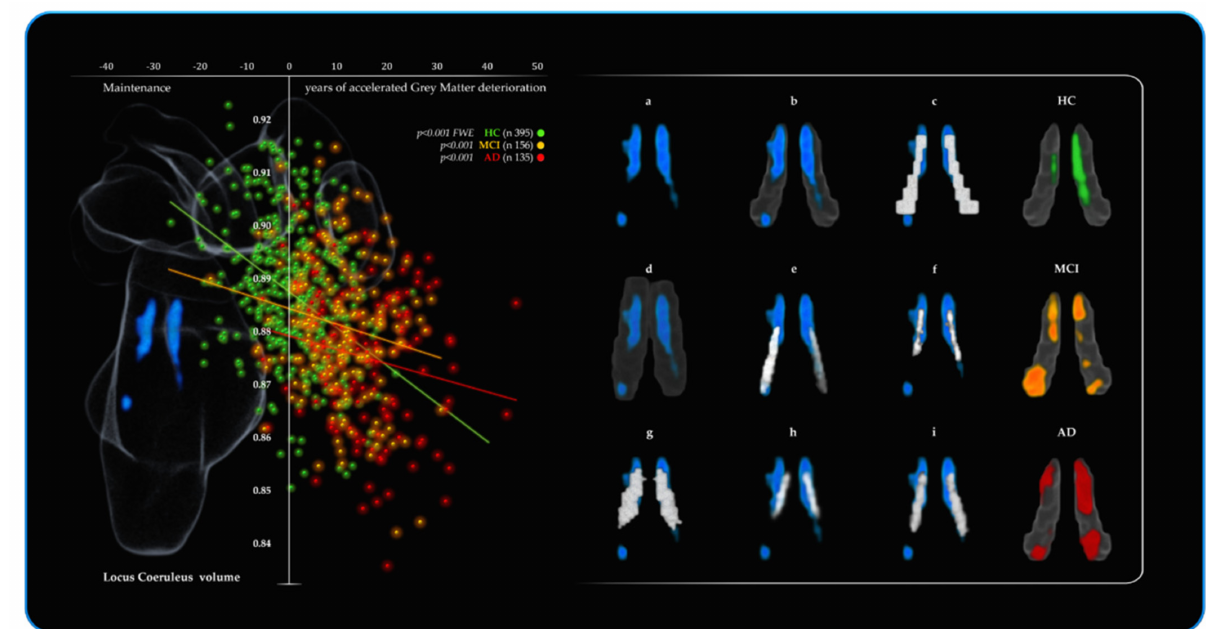
Figure 4. Results from the VBM multivariate linear regression analyses performed in CAT12 for the three groups (HC, MCI, AD). The results are covaried for total intracranial volume (TIV), age and education. The scatterplot displays the relationship between Locus Coeruleus (LC) volume (y axis) and BrainPAD (x axis) for the three groups: green (HC, n.395), orange (MCI, n.156), red (AD, n.135). On the x axis (BrainPAD) are the years of discrepancy between chronological age and the actual biological brain age based on the degree of Grey Matter deterioration. Negative values of BrainPAD mirror a better GM brain maintenance corresponding to a “younger brain age” than the chronological age. Positive values of BrainPAD mirror the accelerated brain’s GM deterioration, namely, positive values correspond to a worse biological maintenance, and to an older brain than the chronological age. The systematic decline of the LC volume across the three groups is related to a progressive accelerated GM deterioration. Indeed, HC values are shifted more towards the upper-left portion of the graph (negative values of BrainPAD and greater LC volume), whereas MCI and AD are more shifted towards the lower-right portion of the graph (positive values of BrainPAD and lower LC volume). On the left portion of the figure, blue shows the average LC results for the three groups (n = 686, p < 0.00001 FWE) on a 3D fronto-lateral view of the Brainstem and the Diencephalon. On the right portion of the figure are the 3D reconstructions (displayed in the MNI152 space) of the results in comparison with previously published LC atlases and masks. ( a ) average LC result; ( b ) average LC result is shown in the LC “omni-comprehensive” mask; ( c ) Keren et al. (2009) [102,107]; ( d ) Tona et al. (2017) [108]; ( e ) Betts et al. (2017) [109]; ( f ) Dahl et al. (2019) [33]; ( g ) Liu et al. (2019) [110]; ( h ) Rong Ye et al. (2020) [111]; ( i ) LC meta-mask by Dahl et al. (2021) [70]. The last column on the right shows the regions of the LC mask negatively related to BrainPAD values for the three groups considered separately: HC n = 395 ( p < 0.001 FWE), MCI n = 156 ( p < 0.001) and AD n = 135 ( p <